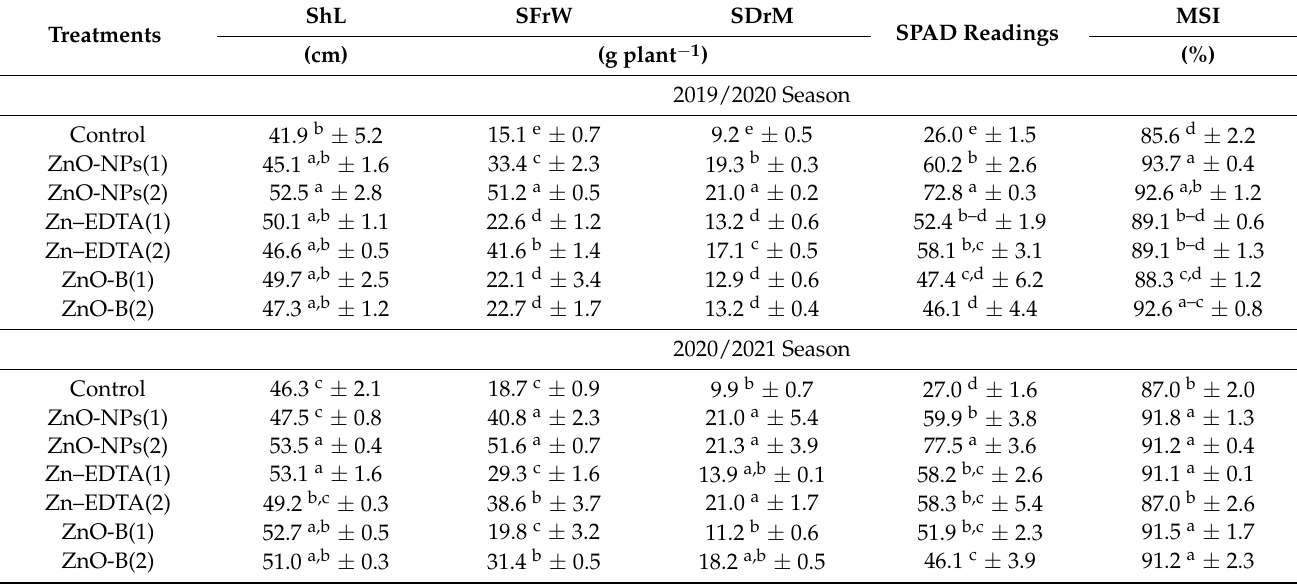
Table 4. Influence of foliar nourishment with some zinc (Zn) forms on some vegetative growth and physiological parameters of carrot plants grown under Zn deficiency stress in two growth seasons.